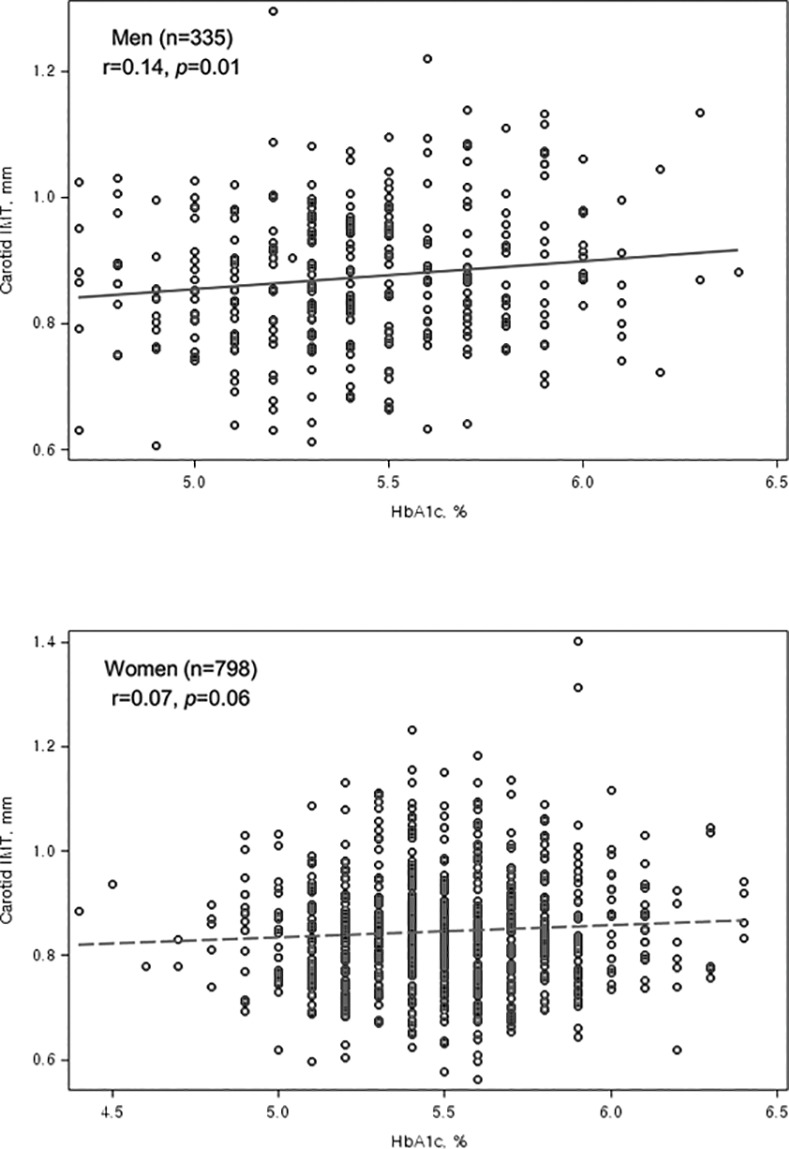
Pearson correlation coefficient and p value between carotid IMT and HbA1c.